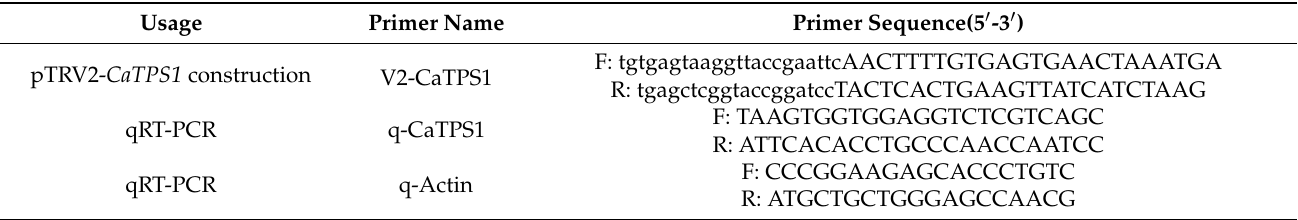
Table 1. List of primers used in this